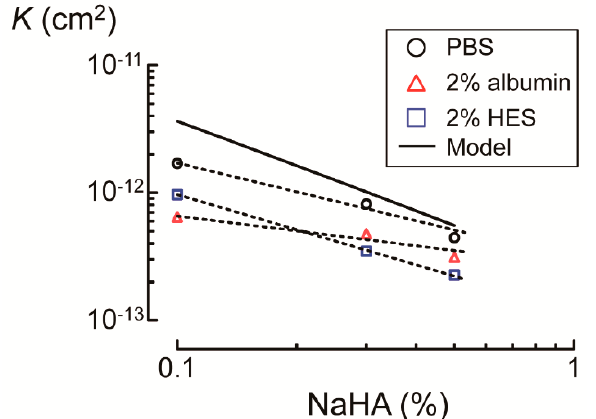
Figure 7. Comparison of Darcy’s permeability coefficients ( K ) of sodium hyaluronic acid (NaHA) solution when phosphate buffered saline (PBS) or 2% colloid solution (i.e., albumin or hydroxyethyl starch (HES)) was infused. Solid line denotes K values calculated by Equation (4) according to the hydrodynamic model of hyaluronic acid polymer networks. Dotted lines denote linear regression lines between logarithmic values of NaHA concentrations and K .